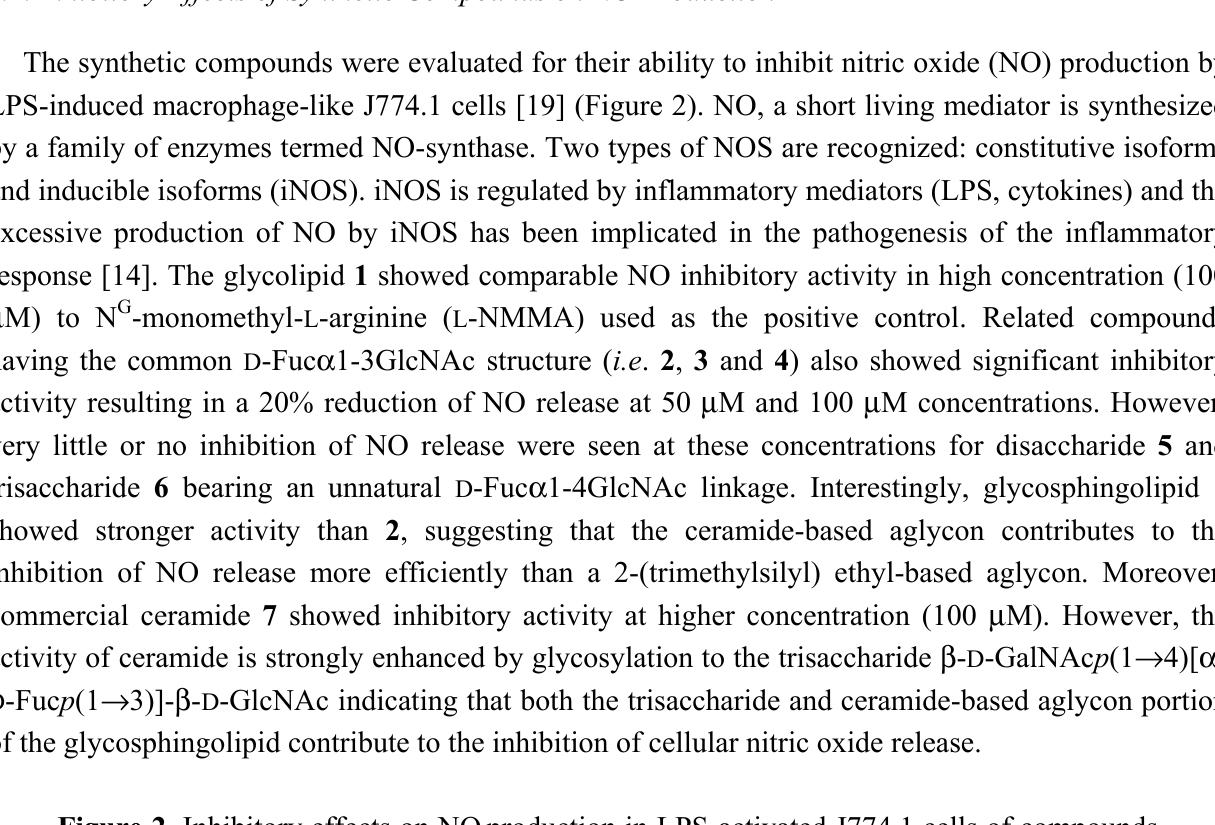
Figure 2. Inhibitory effects on NO production in LPS-activated J774.1 cells of compounds 1 - 7 . Each data represents the mean ± SD for quadruplet experimentals. P: Positive control ( L -NMMA), 50 μ